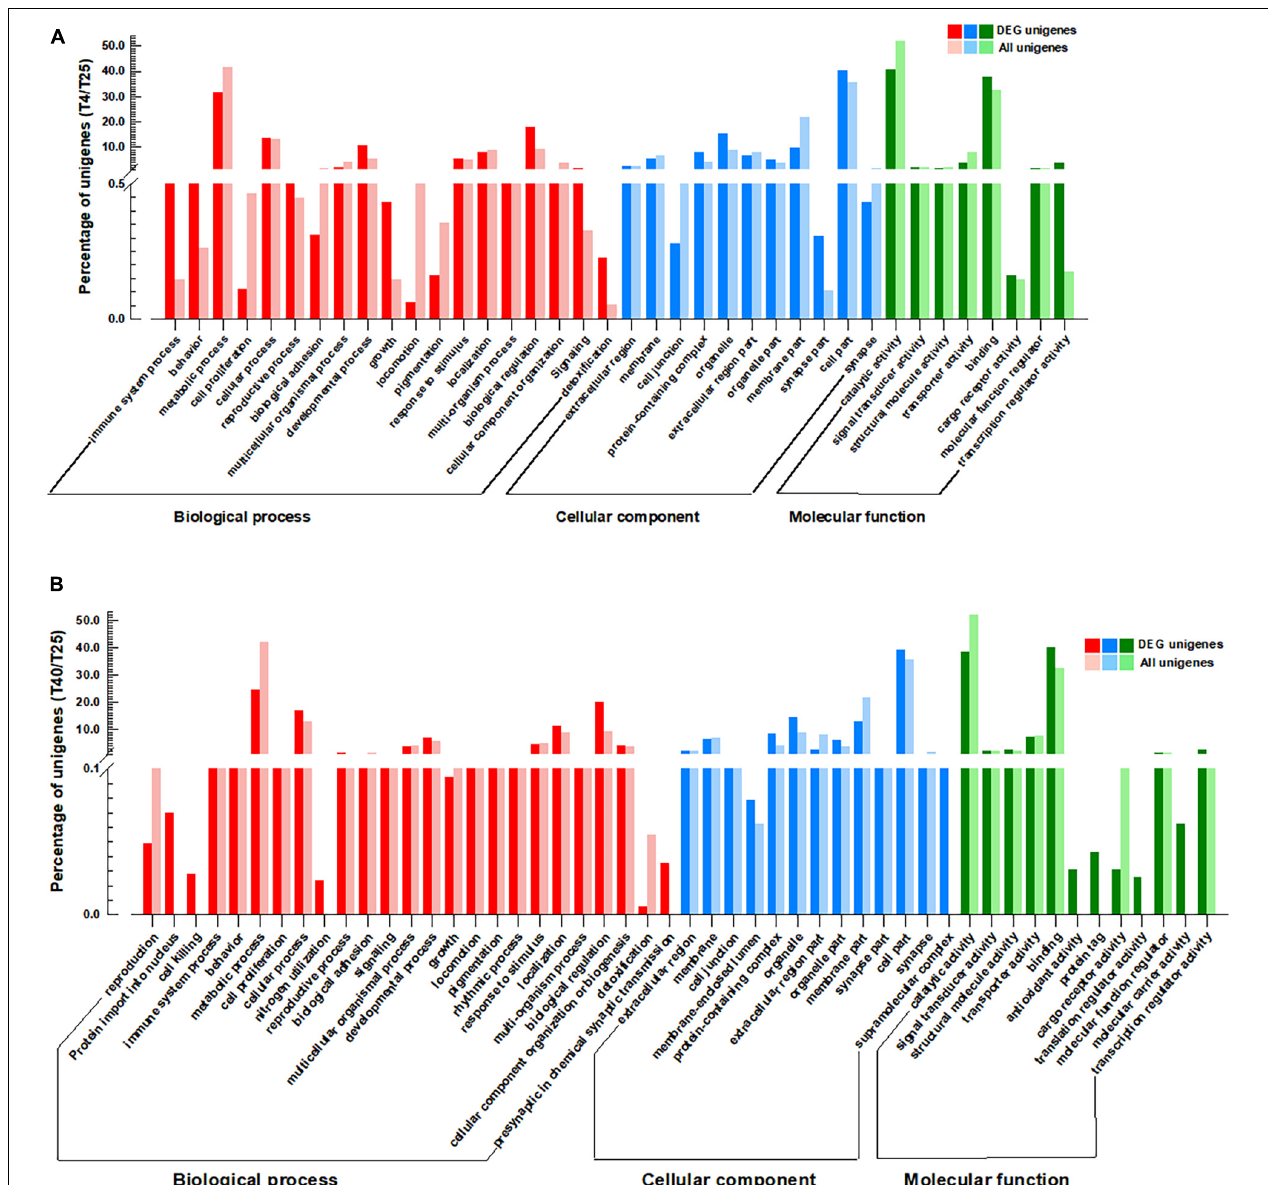
FIGURE 4 | Gene Ontology (GO) analysis. GO annotations of the specific differentially expressed genes (DEGs) ( P -value < 0.05, log 2 FC ≥ 2, ≤ –2) coregulated by cold (A) and high (B) temperature stresses in comparison with T25 as control group. GO terms are summarized in three main categories of “Biological process,” “Cellular component,” and “Molecular function.” The Y -axis shows the percentage of unigenes in each